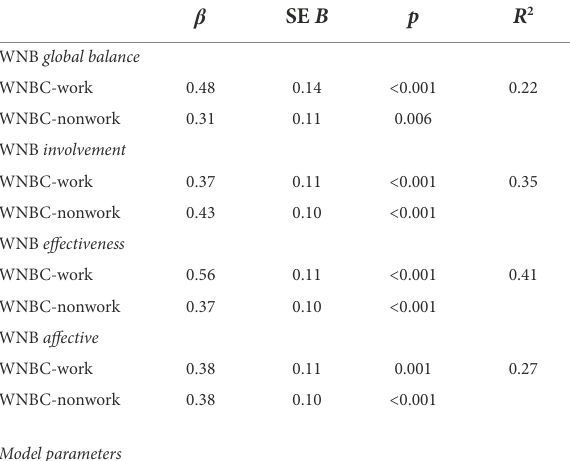
TABLE 7 Structural equation model assessing WNBC on work- nonwork balance (Wayne et al., 2021)